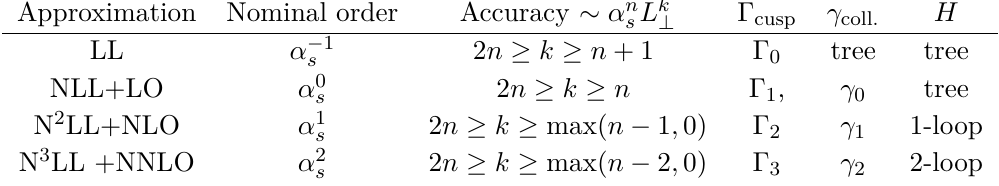
1 /α . The third column states which logarithms ⊥ ∼ s